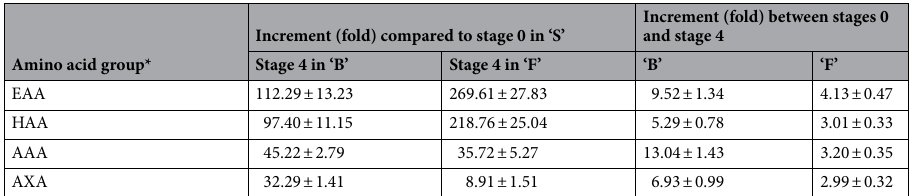
Table 2. Increment of amino acid contents in specific groups by the manufacturing steps and simulated digestion stages. *EAA = essential amino acids: Arg, His, Ile, Leu, Lys, Met, Phe, Thr, Try and Val;